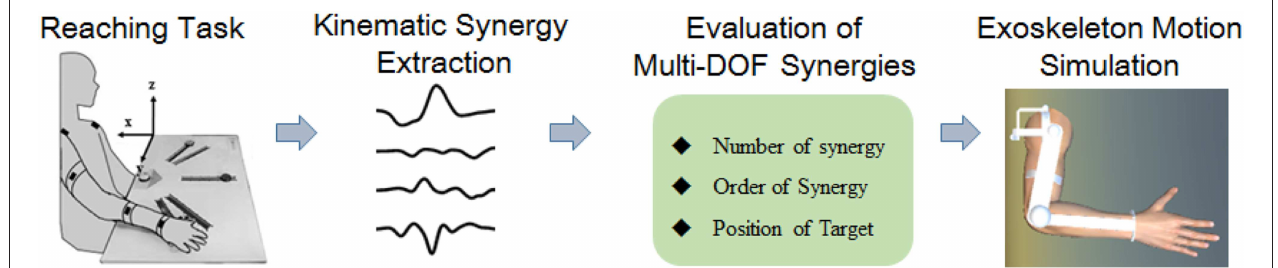
FIGURE 1 | Block diagram of this